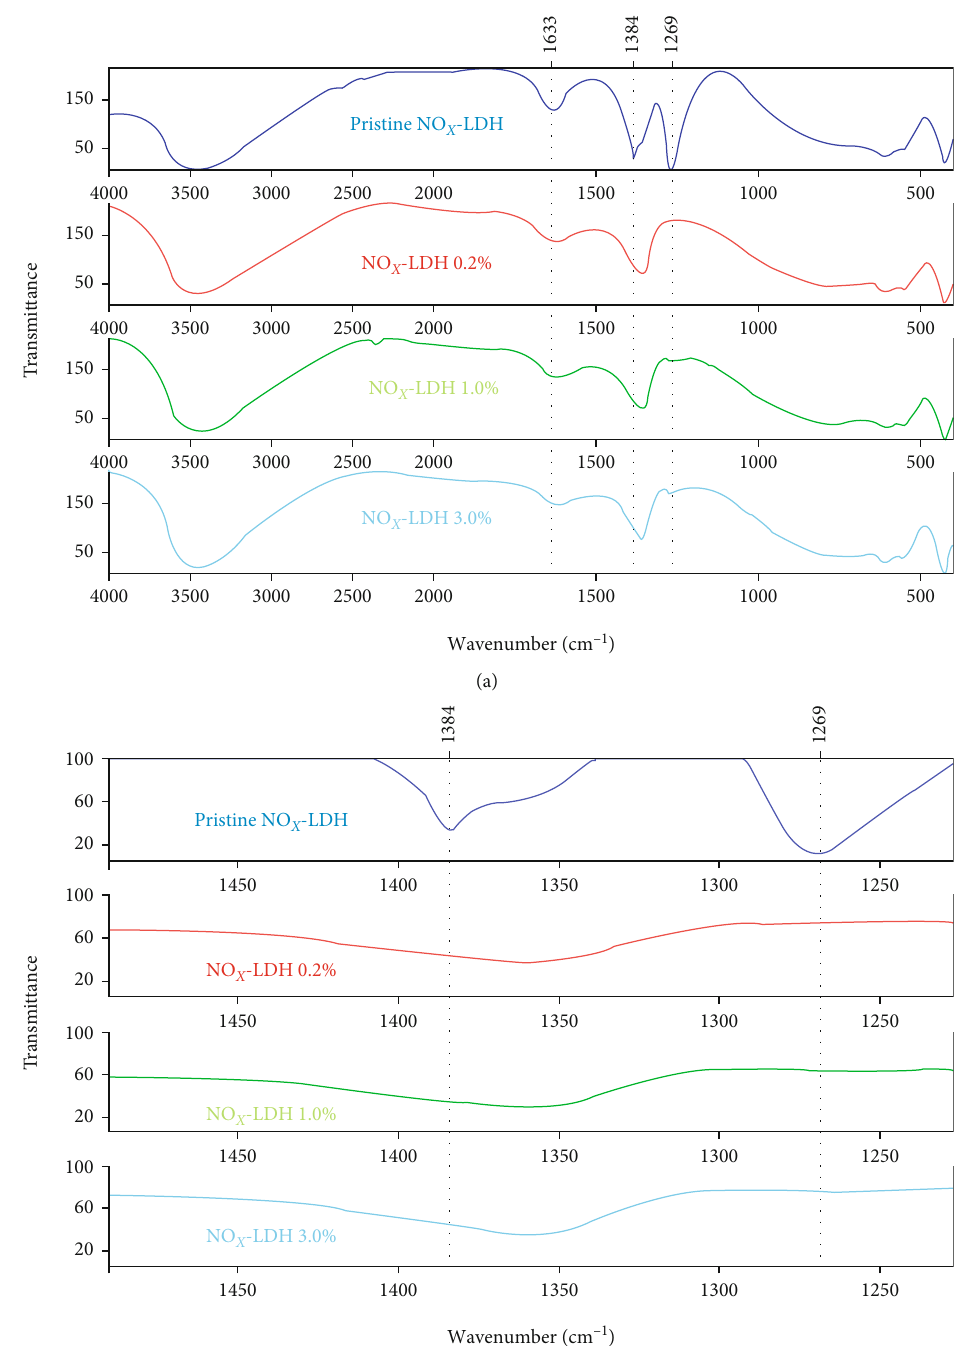
Figure 2: Comparative spectra of pristine NO 1384cm -1